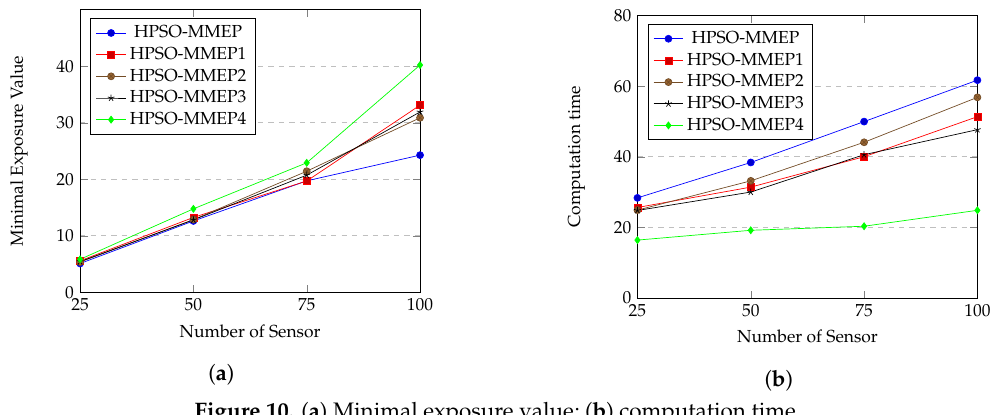
Figure 10. ( a ) Minimal exposure value; ( b ) computation time. Table 4. Different versions of HPSO-MMEP using different genetic operators.